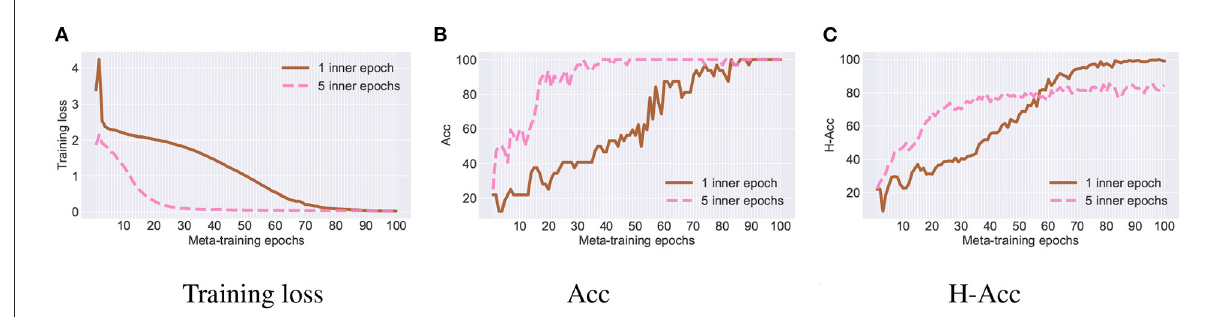
FIGURE5 Ablation study with different number of inner epochs. (A) Training loss. (B) Acc. (C)